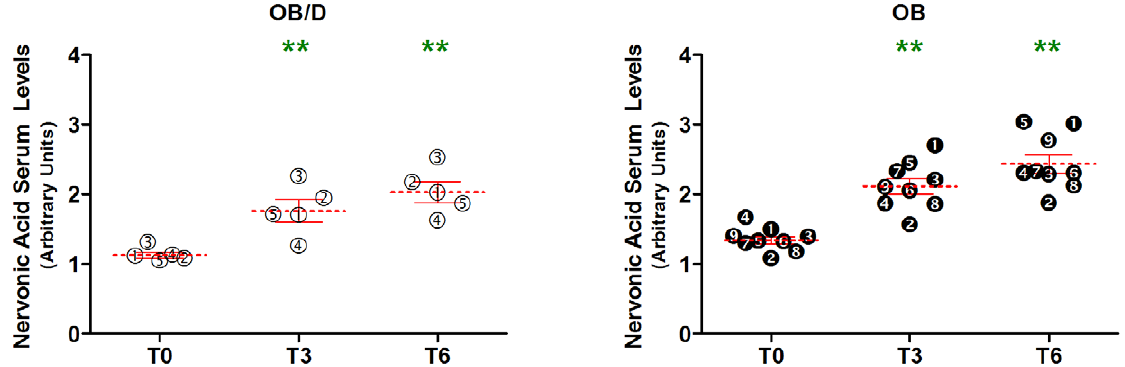
Figure 5. Increases in nervonic acid following RYGB. A significant increase in serum abundance of nervonic acid occurred following RYGB in both OB and OB/D subjects, as assessed using a mixed-effects ANOVA with group:time interaction (** p , 0.01 versus T0). Overall, nervonic acid levels were significantly different at each time point between OB and OB/D subgroups (p , 0.01, see TABLE 2 ). No group:time interaction was identified. Mean metabolite abundance 6 SEM is indicated in red.